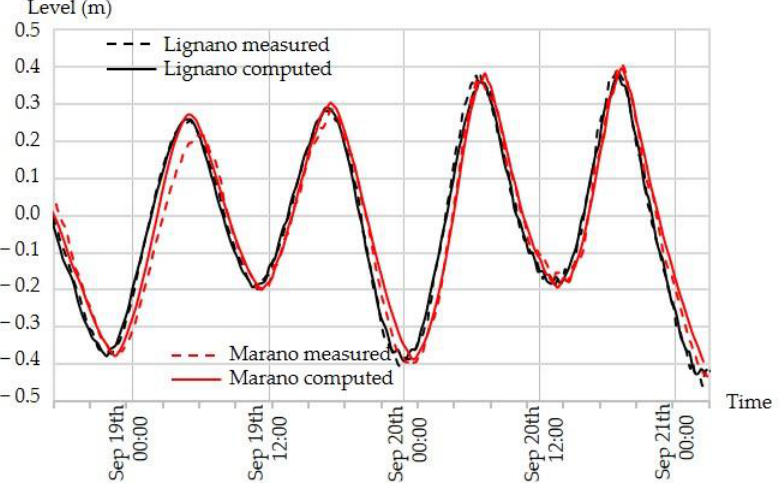
Figure 6. Comparison of measured (dashed lines) and computed (solid lines) water levels at the stations of Marano (red) and Lignano (black) in the period from 18 to 21 September 2014. Root-mean square errors over the entire simulation are evaluated as 0.018 m for Lignano data and 0.033 m for Marano data.